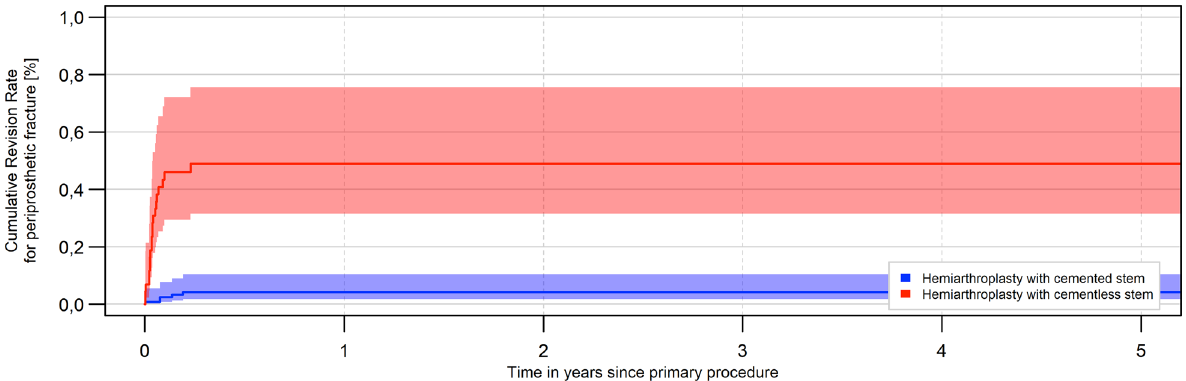
Fig. 3 Development of periprosthetic fractures within the first 5 years after implantation of a cemented or uncemented hemiarthroplasty for the treatment of a femoral neck fracture (log-rank test: p <